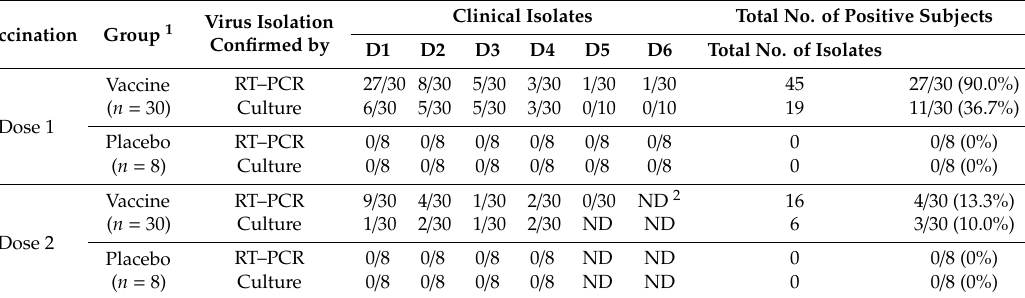
Table 3. Detection of influenza H7N9 LAIV virus in nasal swabs in the 6 days after vaccination or